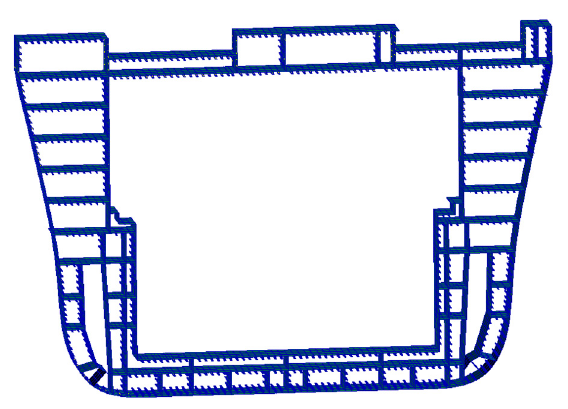
Figure 22. Structural finite element model of the calculation section.